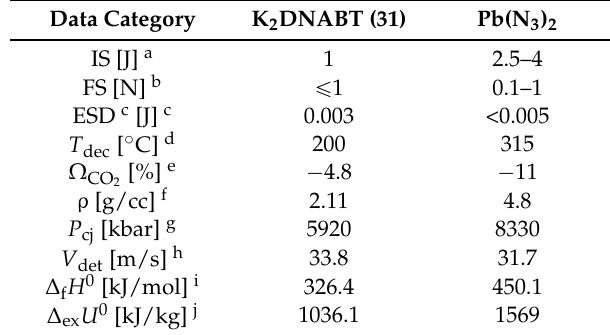
Table 3. Sensitivities and performance of K 2 DNABT as compared to Pb(N 3 ) 2 .